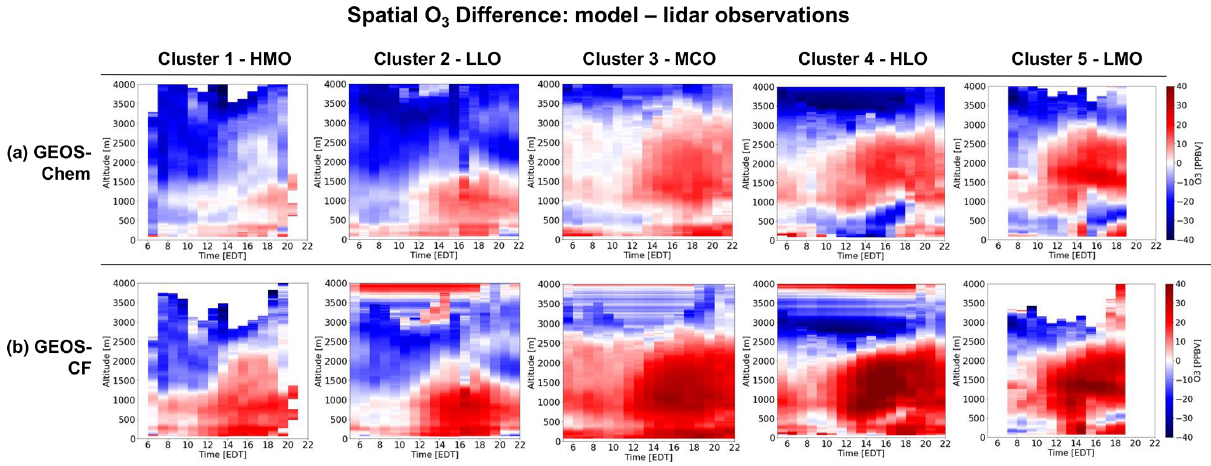
Figure 6. Mean profile curtain spatial O 3 difference (model–lidar observations) for each cluster (1–5). GEOS-Chem differences (a) and GEOS-CF differences (b)